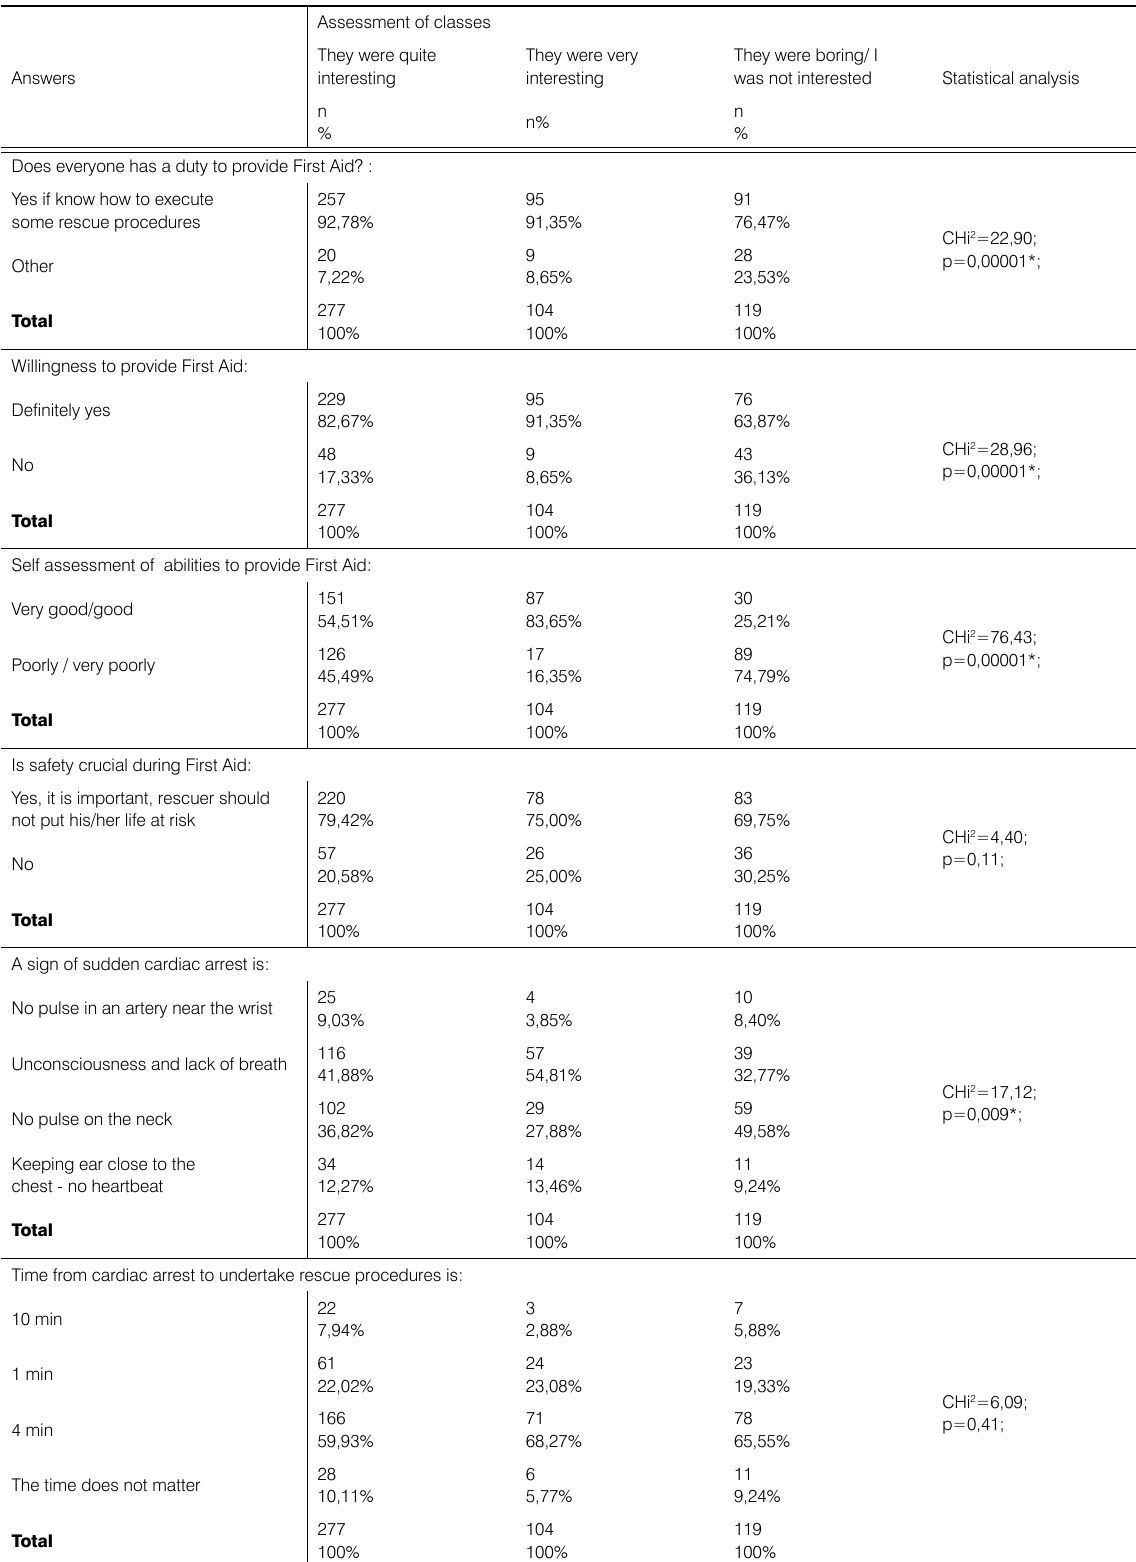
Table 1. Assessment of First Aid classes among secondary school students and its correlation with their knowledge Answers